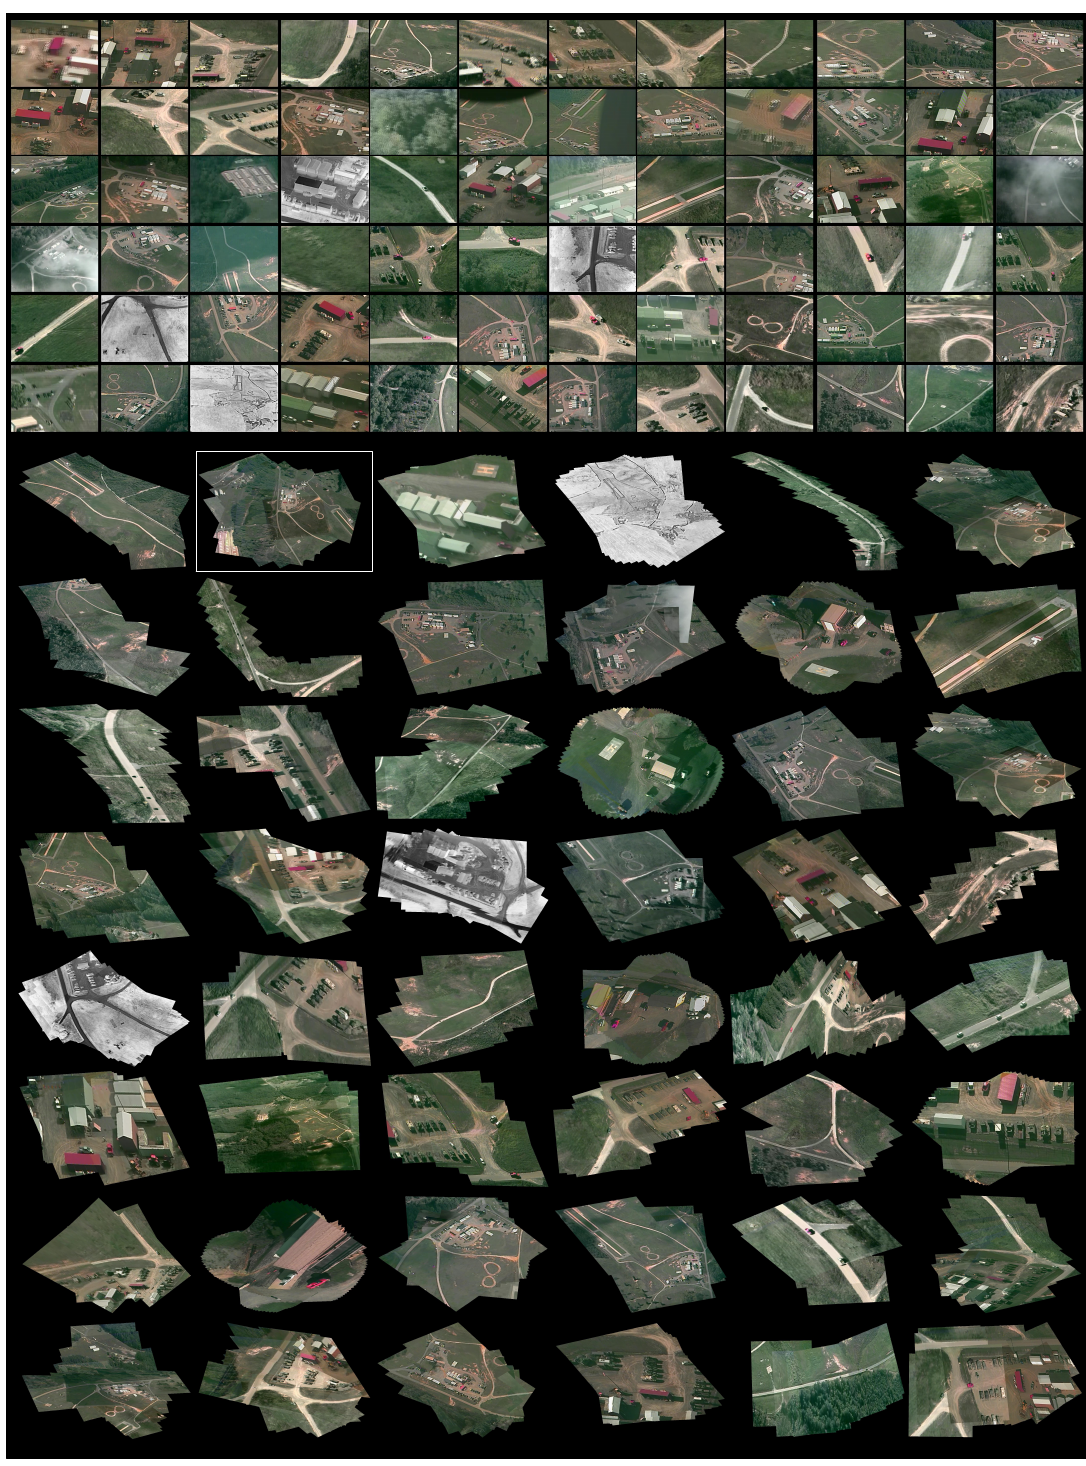
Figure 7. Our diverse scene stitching results from the VIRAT dataset with 2312 images. (Top) Examples of input VIRAT images. (Bottom) 48 panoramas of diverse scene by our approach after only 15 min and 33 s. The dynamic stitching results of panorama with the white bounding box are shown in Figure